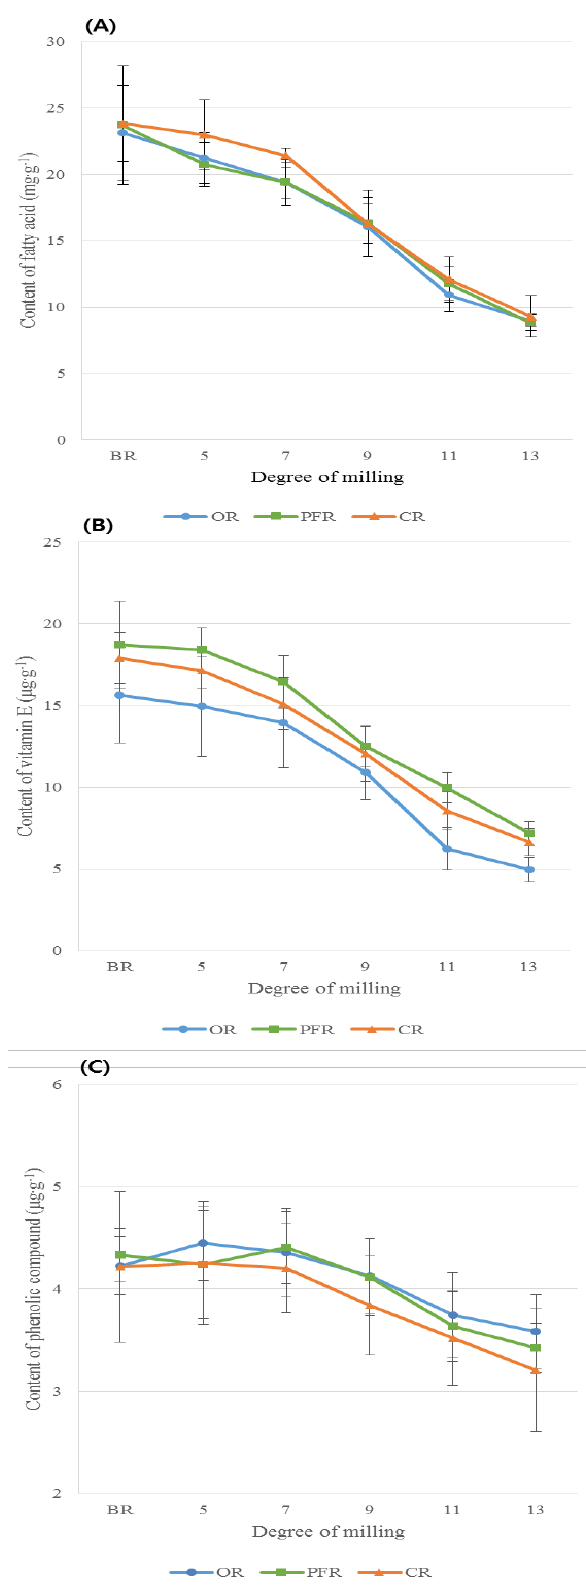
Figure 5. Comparison of ( A ) total fatty acid, ( B ) total vitamin E, and ( C ) total phenolic compound levels by rice type depending on the degree of milling.